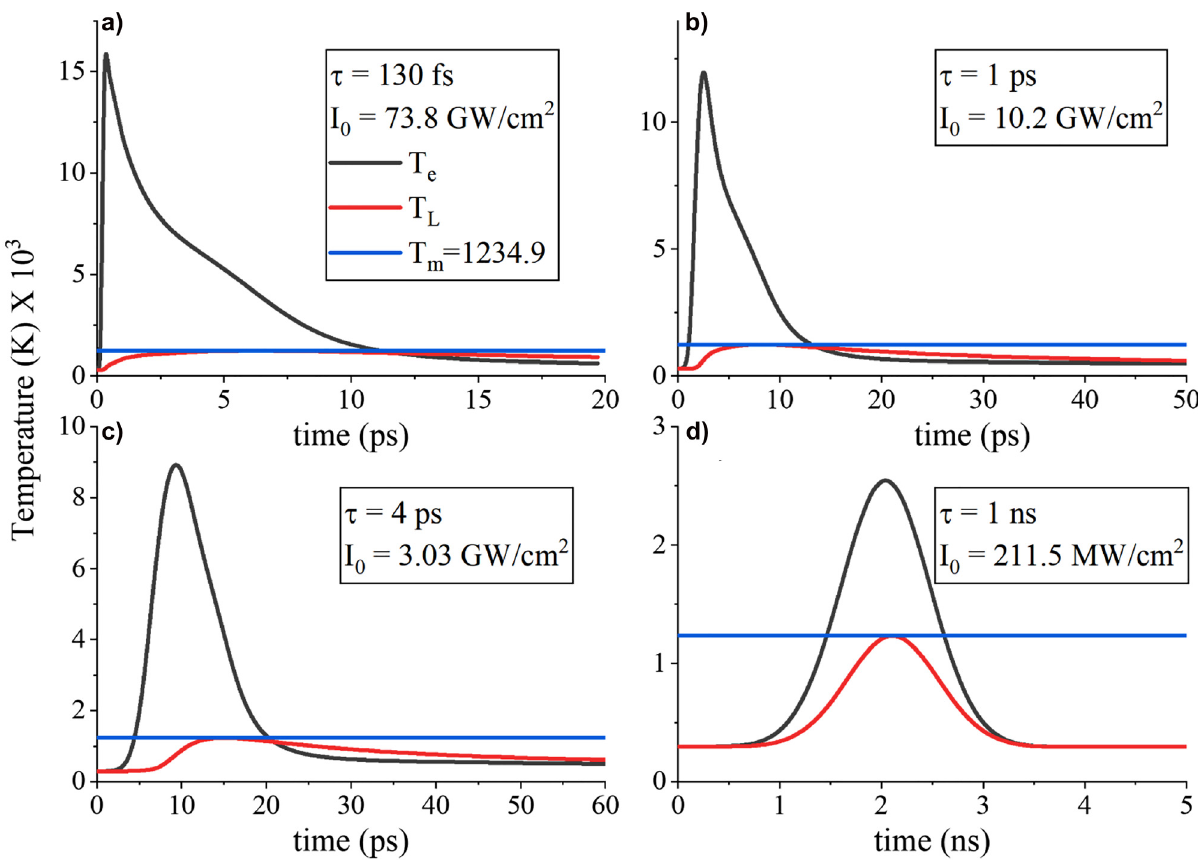
Figure 8: Damage (breakdown) study of the presented gap-plasmon metasurfaces. The induced lattice and electron temperatures for (a) ul- trashort femtosecond, (b) one picosecond, (c) four picoseconds, and (d) slower one nanosecond laser pulse illuminations. The constant blue line depicts the melting temperature of